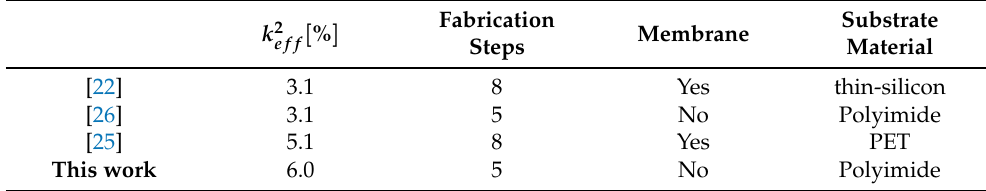
Table 3. Comparison of flexible FBARs.